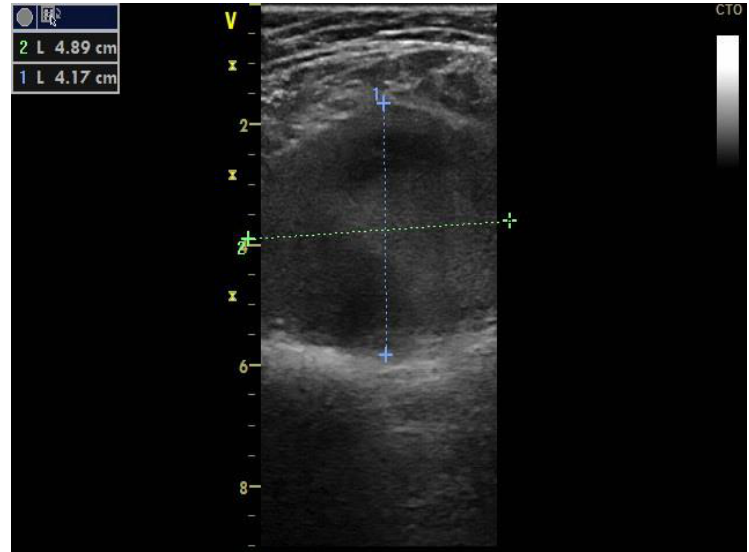
Figure 1. Proximal left popliteal vein transverse axis view demonstrates a simple saccular dilatation, with partial thrombosis. The dotted lines represent the PVA’s dimensions.